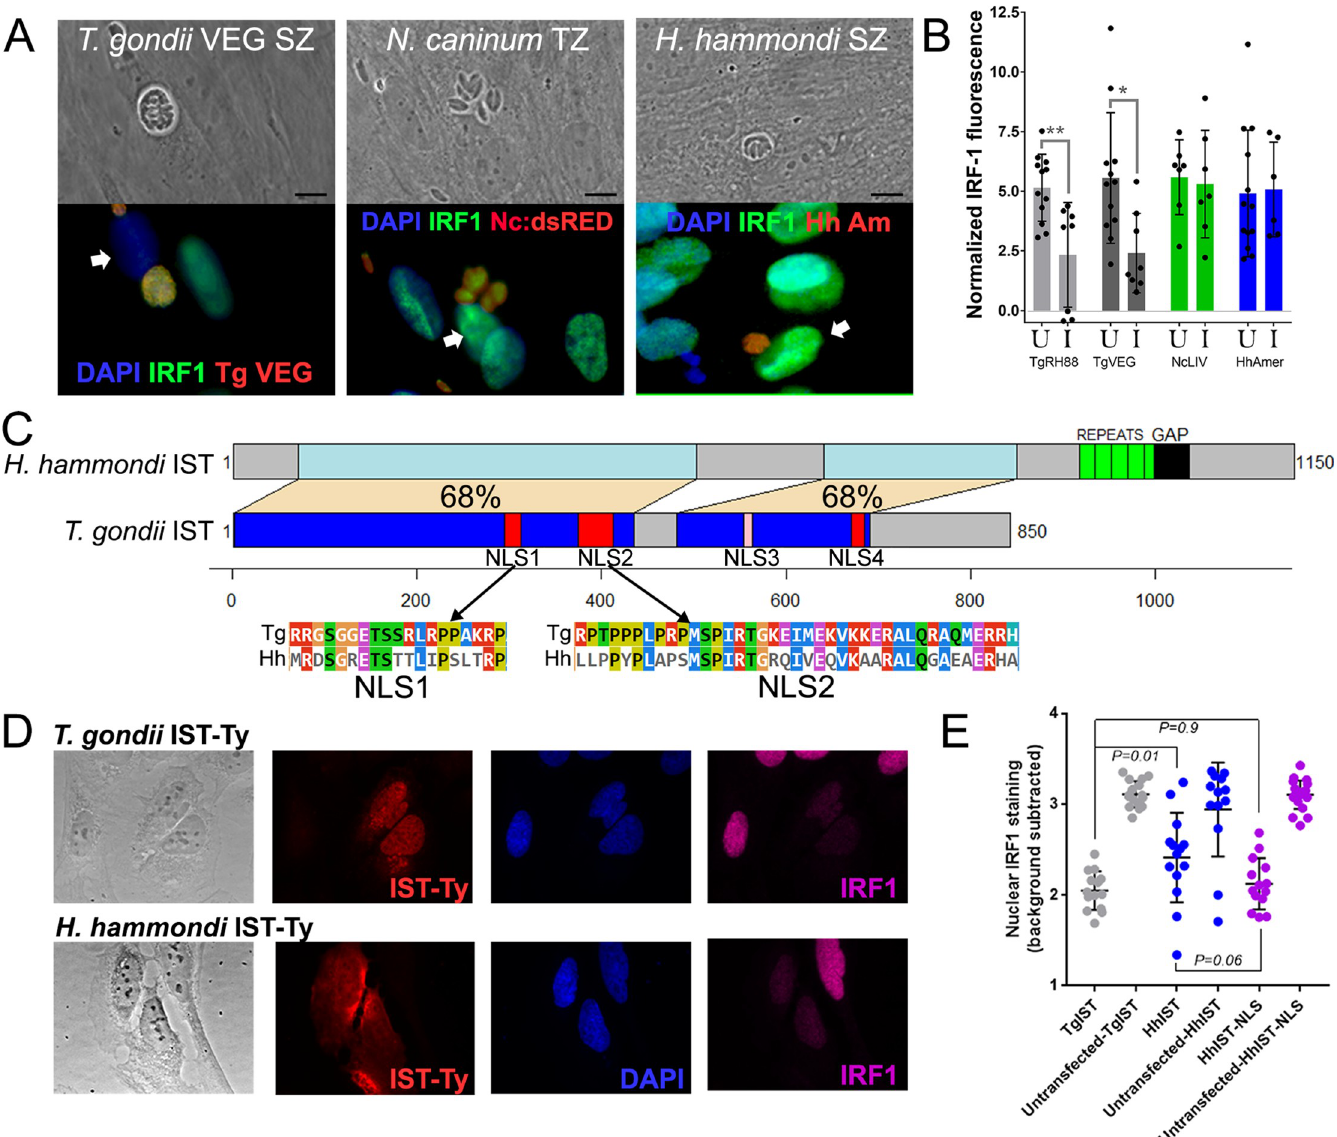
Fig 8. H . hammondi IST lacks suppressive activity compared to T . gondii IST due to differences in putative NLS sequences and localization in the host cell. A) In contrast to T . gondii , H . hammondi and N . caninum infection fails to suppress IFN γ -induced IRF1 activation. Representative images are shown for each species, and the white arrowhead indicates the likely nucleus of the infected cell. As expected T . gondii infected cells have reduced IRF1 staining compared to uninfected neighboring cells while cells infected with N . caninum or H . hammondi have similar IRF1 nuclear staining as uninfected bystander cells. (B) Quantification of IRF nuclear staining in cells infected with each indicated species (I) and uninfected bystander cells (U). T . gondii infection (strains RH88 and TgVEG) significantly reduced IFN γ -induced IRF1 nuclear staining while infection with N . caninum and H . hammondi did not. (C) Schematic of the predicted IST protein coding sequence gene from T . gondii and H . hammondi , showing conserved (blue and light blue connected by tan) and non-conserved (grey) regions of the predicted proteins. Putative NLS sites are indicated in red or pink, and were only found in T . gondii IST (not H . hammondi IST). H . hammondi has a longer predicted protein that includes repetitive sequence (green) and a sequence assembly gap (black). (D) Ectopic expression of Ty-tagged T . gondii and H . hammondi IST in U20S cells showing primarily nuclear staining for TgIST-Ty in contrast to cytoplasmic and nuclear staining for HhIST-Ty. Cell expressing TgIST and HhIST show reduced IRF1 staining in the nucleus after IFN γ treatment. (E) Quantification of nuclear IRF1 staining in IST-expressing cells and neighboring bystanders lacking IST expression. Constructs were TgIST-Ty, HhIST-Ty and HhIST-NLS-Ty (Ty-tagged WT HhIST with a C-terminal NLS). Inclusion of an NLS on the C-terminus of H . hammondi IST increased its ability to suppress IRF1 induction by IFN γ treatment compared to